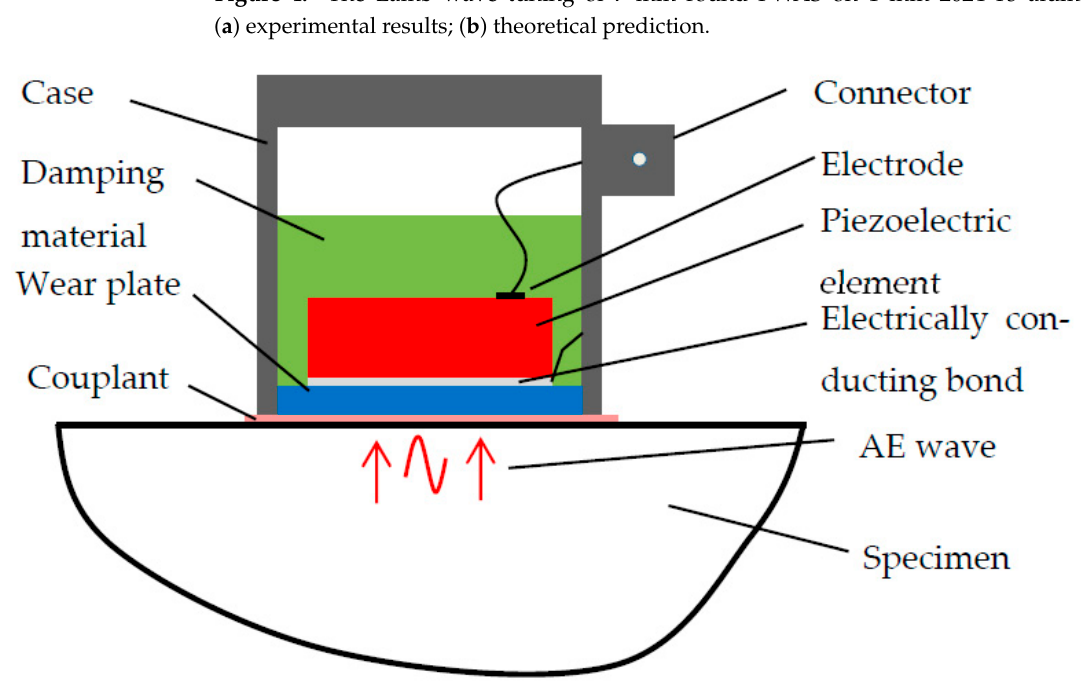
Figure 5. Schematic of a typical AE sensor.